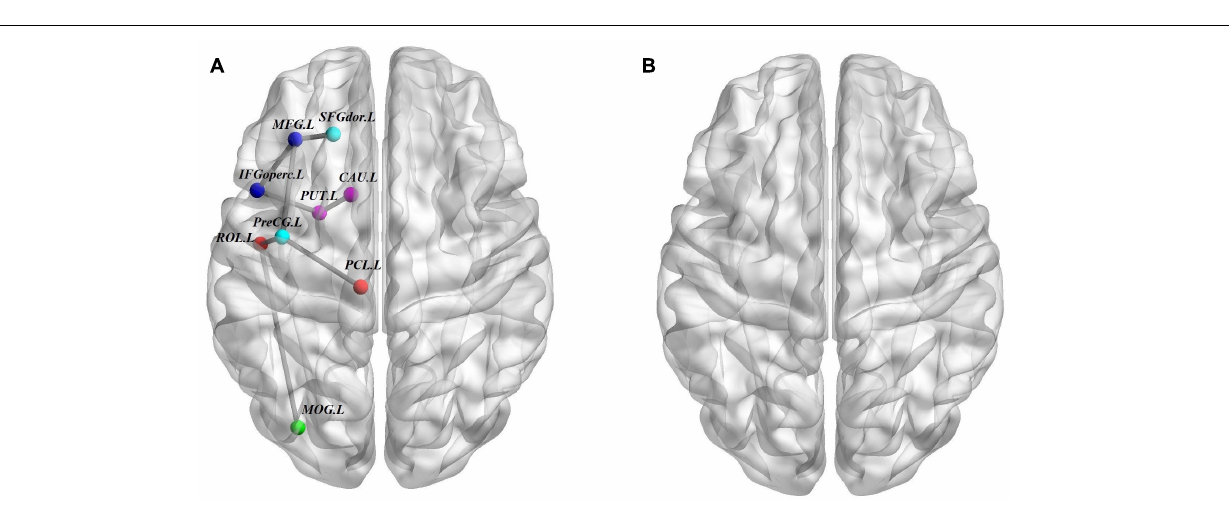
FIGURE 3 | Structural connectivity (SC) differences. (A) The structural connectome network differences among ASD, ADHD, and TD groups identified by NBS; these connections formed a single connected network with nine nodes and eight connections ( p = 0.001, corrected). (B) Similar to A but between ASD and ADHD groups, no connected components with significant differences were found. For the definitions of the abbreviations, see Table 1 . The nodes and connections were mapped onto the cortical surfaces using BrainNet viewer software (www.nitrc.org/projects/bnv/). Note that the FN-weighted WM network for each participant was constructed using the AAL